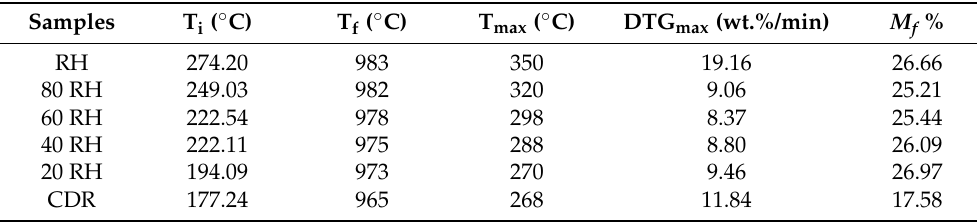
Figure 1. TG and DTG curves of RH ( a ) and CDR ( b ) from 25 to 1000 °C. Table 3. Pyrolysis parameters for all samples.